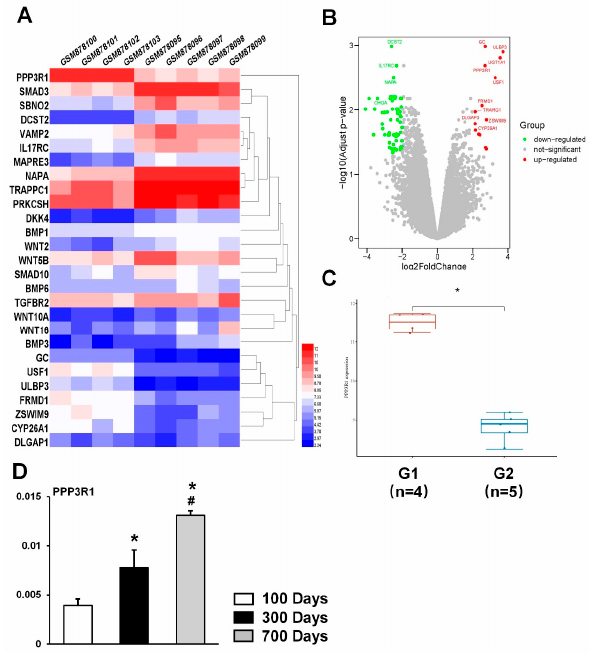
Figure 1. PPP3R1 is activated in senescent BMSCs. ( A ) The heatmap of the differential gene expression; different colors represent the trend of gene expression in different tissues. ( B ) Volcano plot: The volcano plot was constructed using the fold change values and P-adjust. Red dots indicate upregulated genes. Green dots indicate downregulated genes. ( C ) The expression distribution of PPP3R1 gene in different tissue. The abscissa represents different groups of samples, and the ordinate represents the expression distribution of the gene; different colors represent different groups. ( D ) Expression levels of PPP3R1 in BMSCs from mice of different ages. * p < 0.05. # p < 0.05 vs. 300 Days